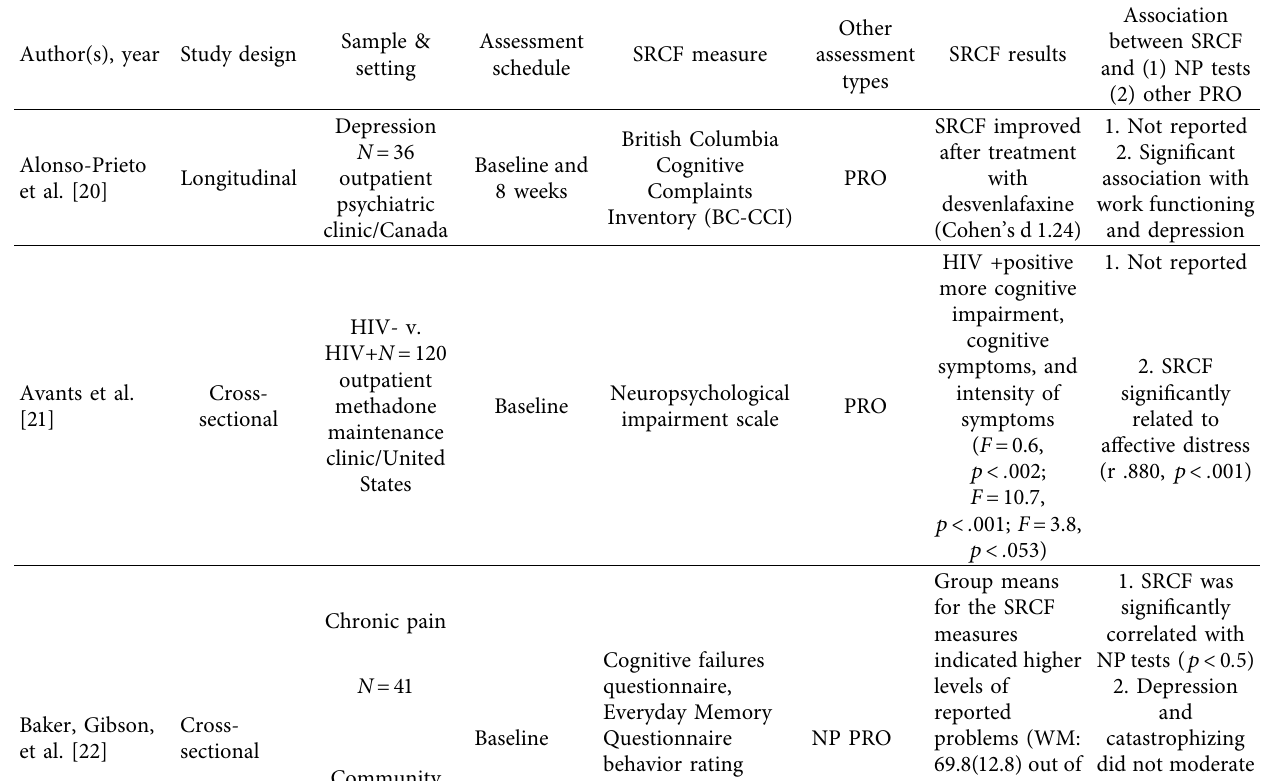
Table 1: Summary of included